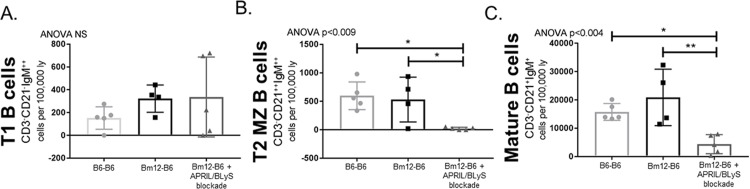
APRIL/BLyS blockade significantly depleted mature B and transitional 2 (T2) marginal zone B lymphocyte subsets, but preserved immature B lymphocytes.Flow cytometry was used to assess immature and mature B lymphocyte populations in spleen. Each graph shows number of cells per 100,000 lymphocytes. (A) T1 B cells were defined as CD3-CD21-IgM++. (B) T2 marginal zone B cells were identified as CD3-CD21++IgM++. (C) Mature B cells were defined as CD3-CD21+IgM+. *p<0.03, **p<0.004.